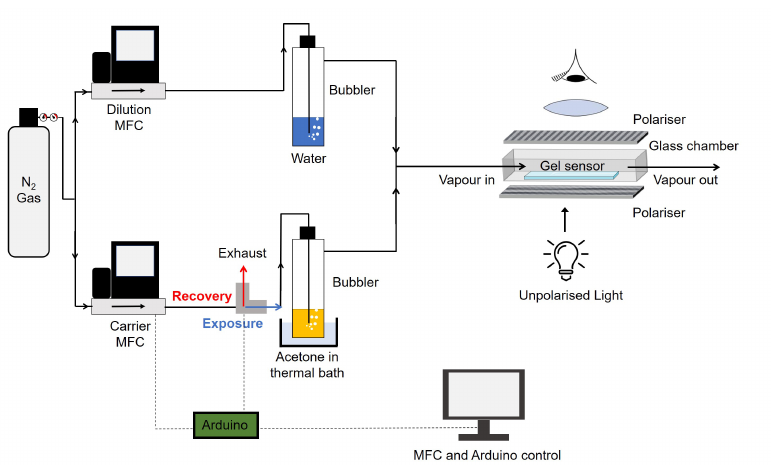
Figure 2. Gas delivery system used to generate controlled concentrations of acetone vapours and send them to the sensor chamber positioned in a polarised optical microscope. Two mass flow controllers (MFC) allow to mix acetone and humid nitrogen vapours in different proportions, and the electro-valve (in grey) switches between exposure and recovery stages. The MFCs and electro-valve are controlled by an Arduino